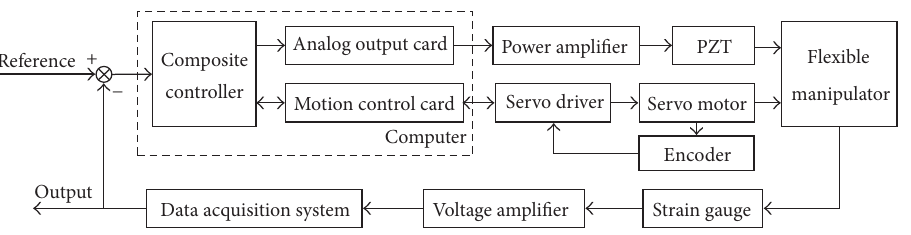
Figure 13: Flowchart of the composite control